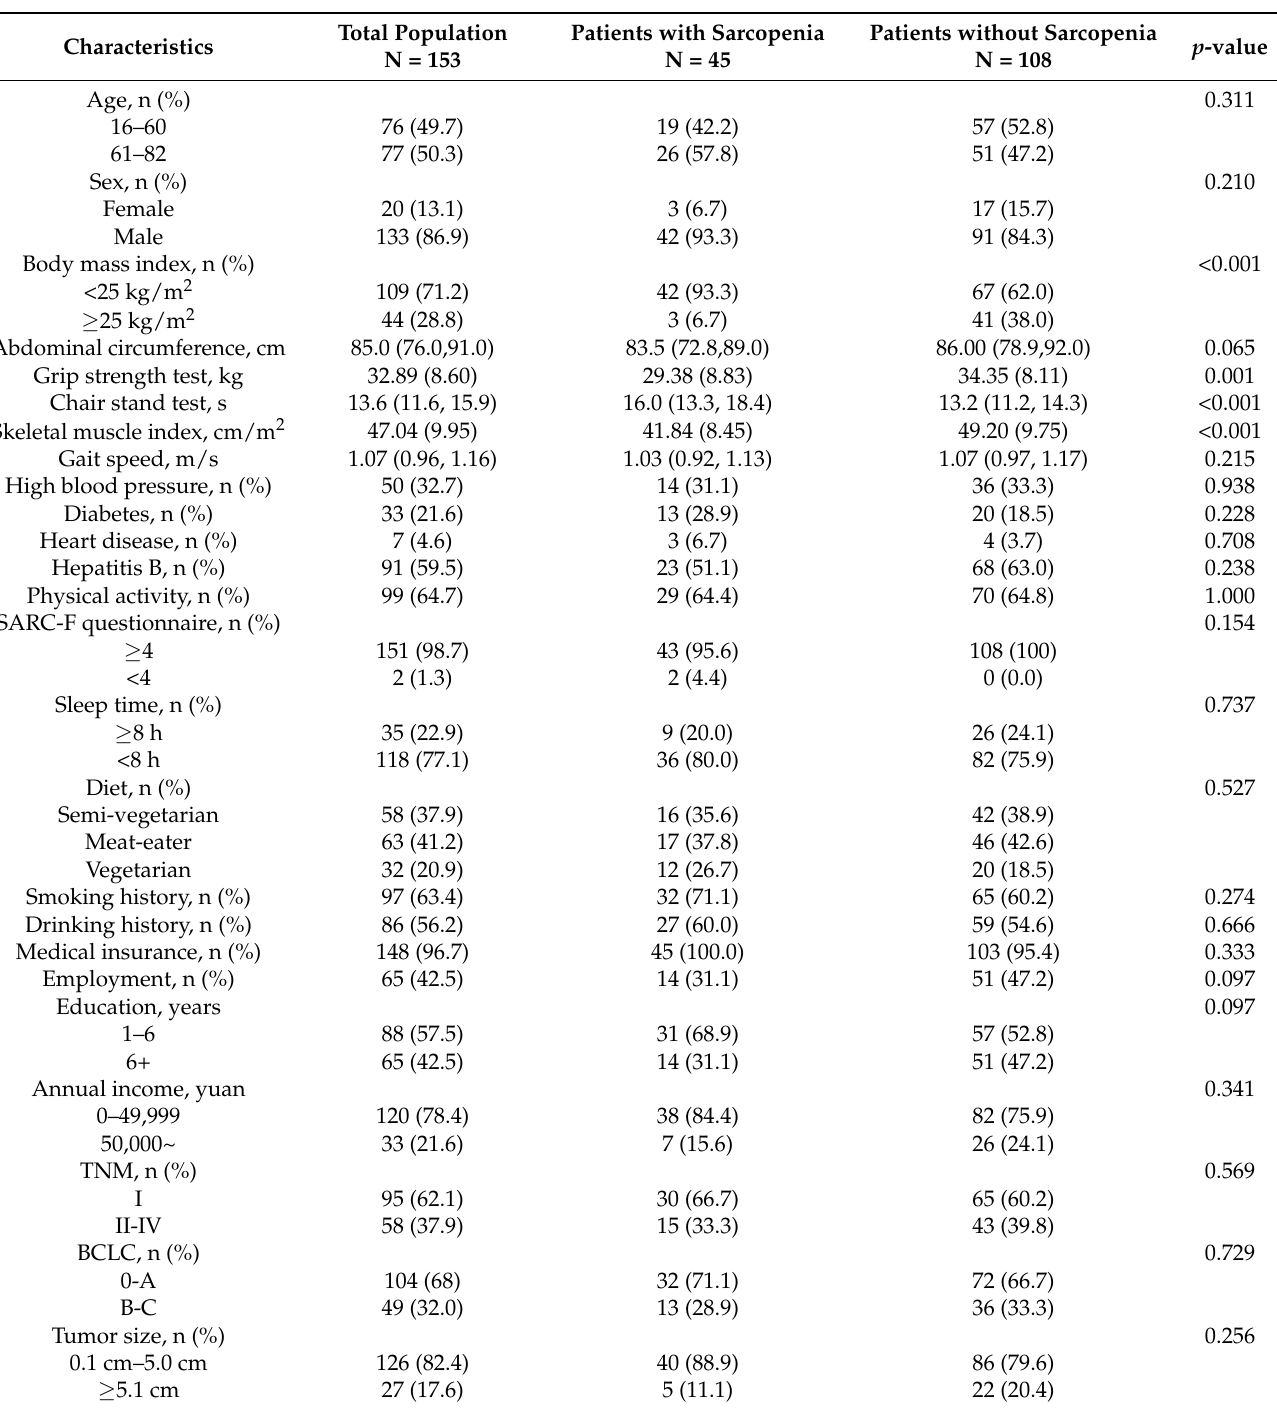
Table 1. Clinical characteristics and outcomes of the total population, patients with sarcopenia, and patients without